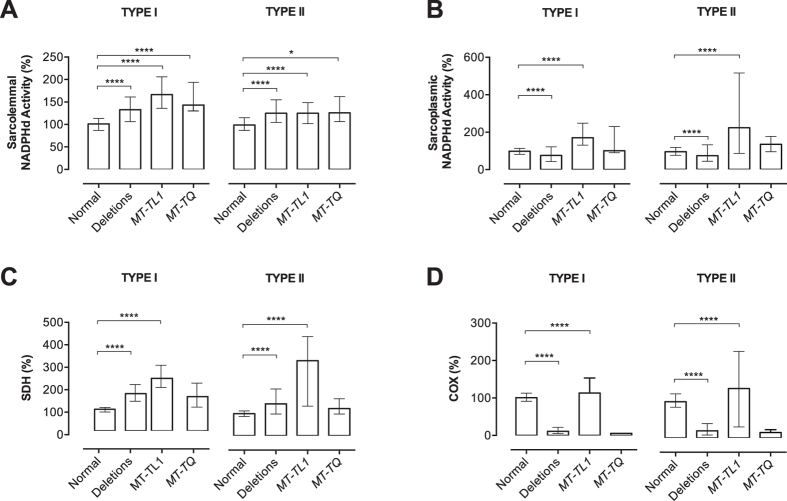
NADPHd activity and genotype in individual muscle fibres.Quantification of NADPHd staining show increased sarcolemmal activity in both types I and II abnormal fibres, regardless of the kind of mutation (A). Sarcoplasmic NADPHd activity is also significant increased in patients with MT-TL1 mutations but decreased in those with mtDNA deletions (B). A similar pattern is shown when we analyze SDH (C) and COX (D) staining in the same groups of fibres classified according to the genotype. SDH activity is increased in fibres with mtDNA deletions and MT-TL1 mutations. COX activity is increased in MT-TL1 mutations but reduced in mtDNA deletions. Total numbers of myofibres analysed: deletions (type I: n = 484; type II; n = 392); MT-TL1 (type I: n = 141; type II: n = 72); MT-Q (type I: n = 9; type II: n = 6) and normal (type I: n = 418; type II: n = 332). Data were analyzed by Kruskal-Wallis test followed by Dunn’s post hoc test. ****P ≤ 0.0001; *P ≤ 0.05. Bars are showing median and interquartile range.